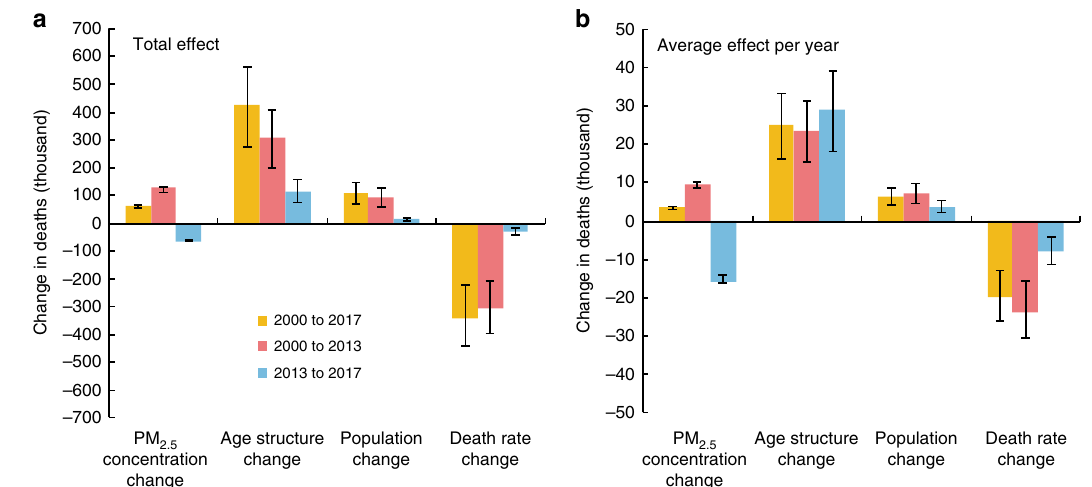
Fig. 3 Contributions of different factors to changes in deaths attributable to PM 2.5 pollution (DAPP) between 2000 – 2013 and 2013 – 2017. a The total effects in different periods, the sum of the effect caused by different driving factors in each period equals the net change in DAPP. b the average effects per year, which equals the total effect divided by the length of each period. Error bars represent 90% con fi dence intervals. Yellow, red and blue bars represent different periods (2000 – 2017, 2000 – 2013, 2013 – 2017). Source data are provided as a Source Data fi le.